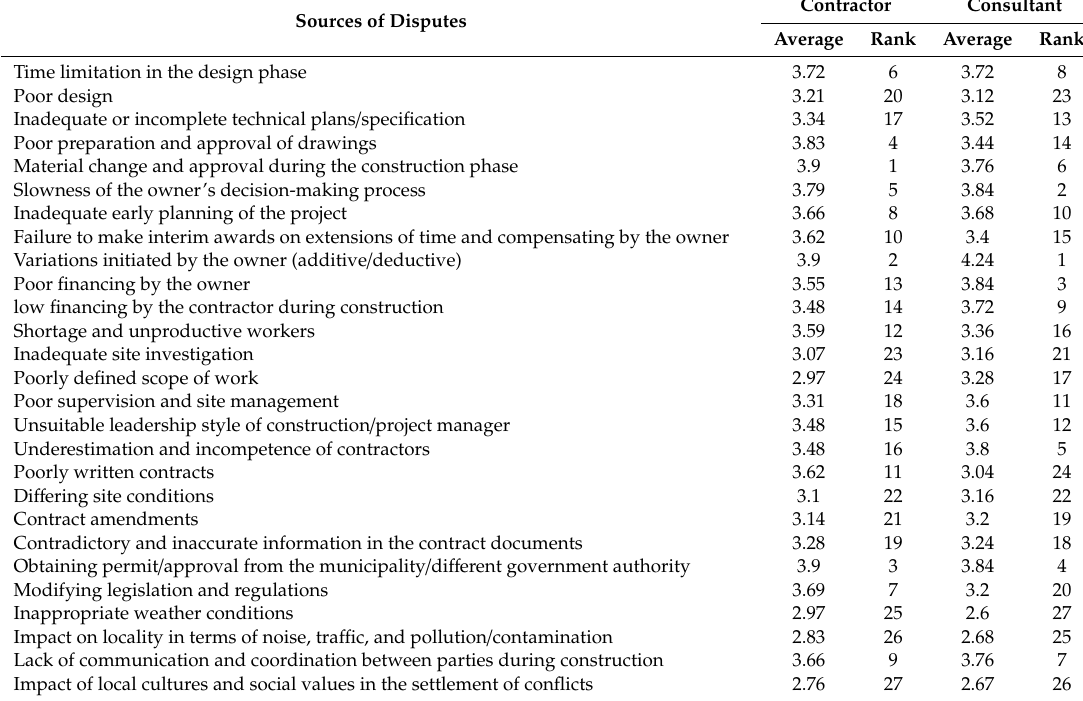
Table 7. Sources of disputes—comparative results (contractors vs.